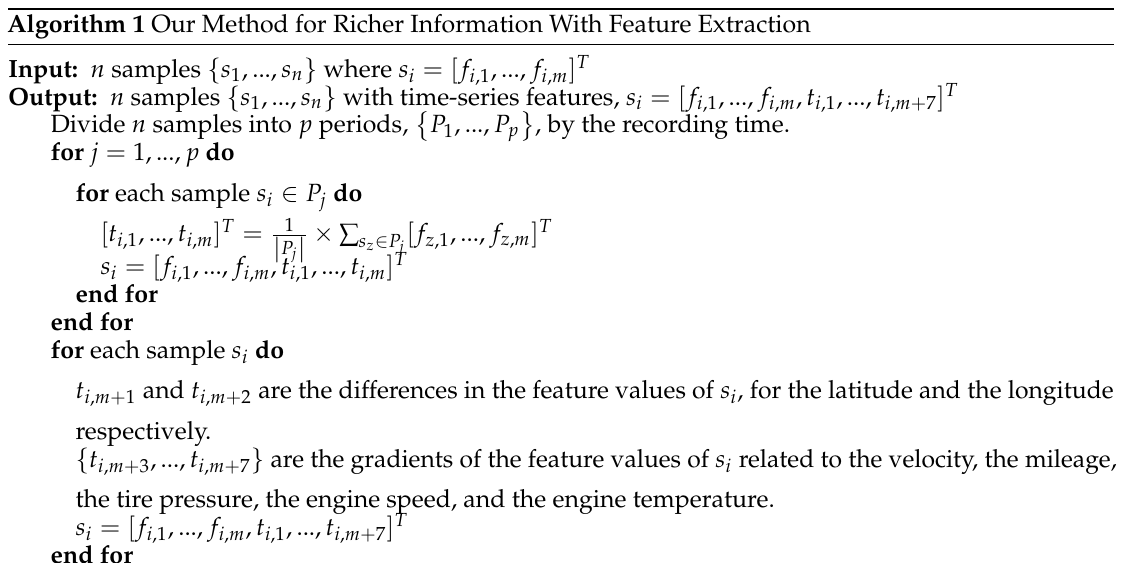
Algorithm 1 Our Method for Richer Information With Feature